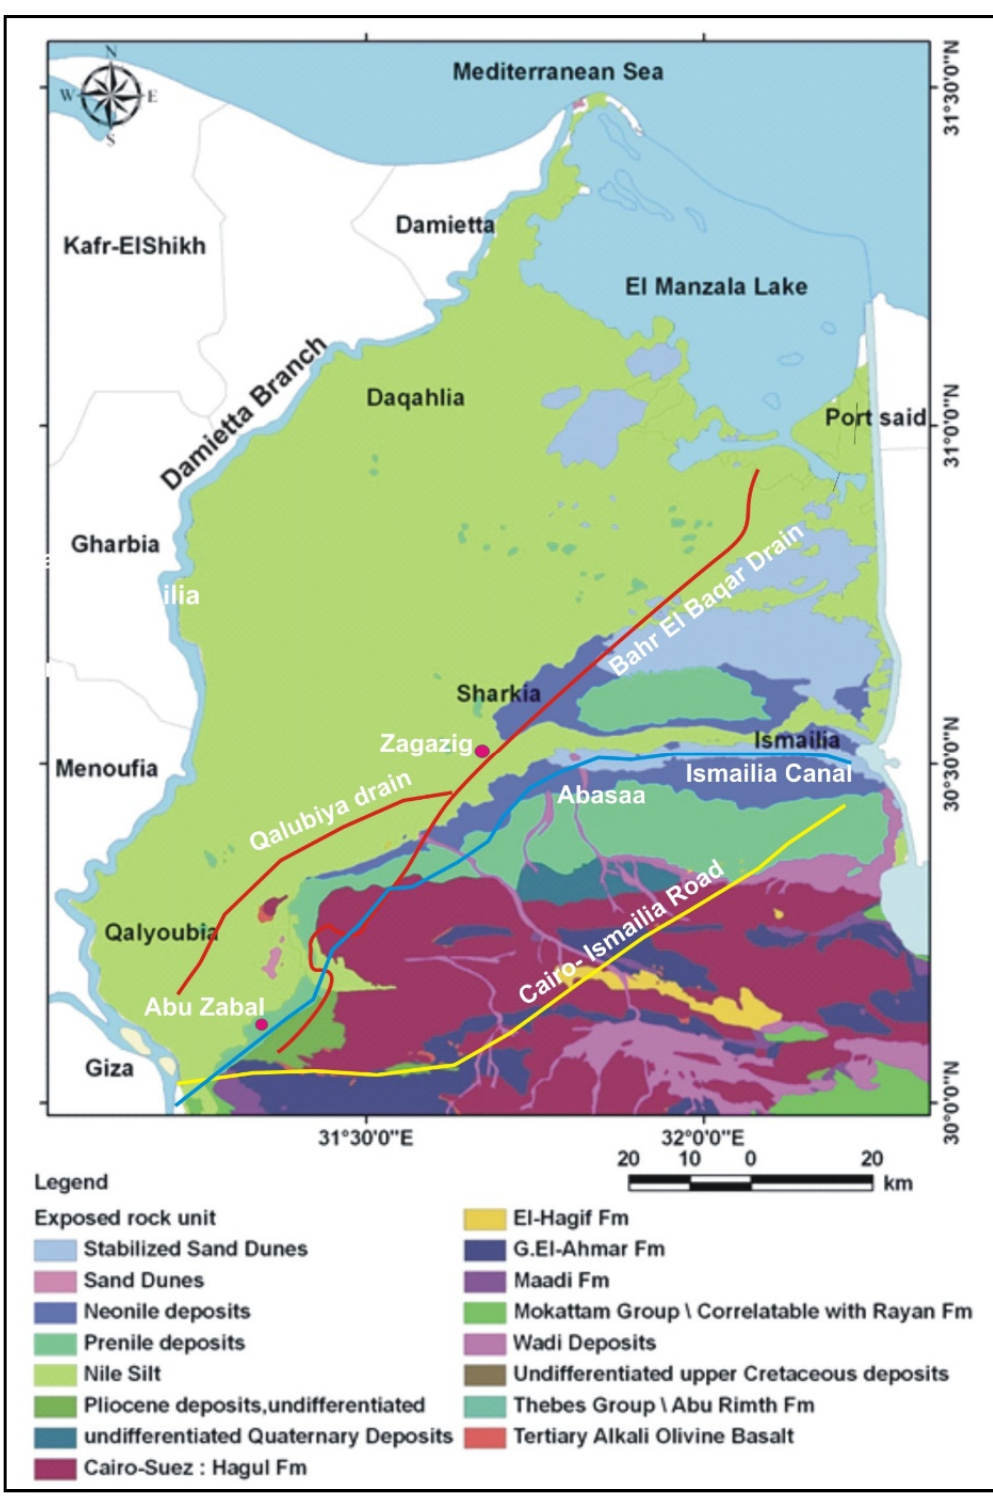
Figure 1. Geologic map of eastern Nile Delta (modified after [21]).